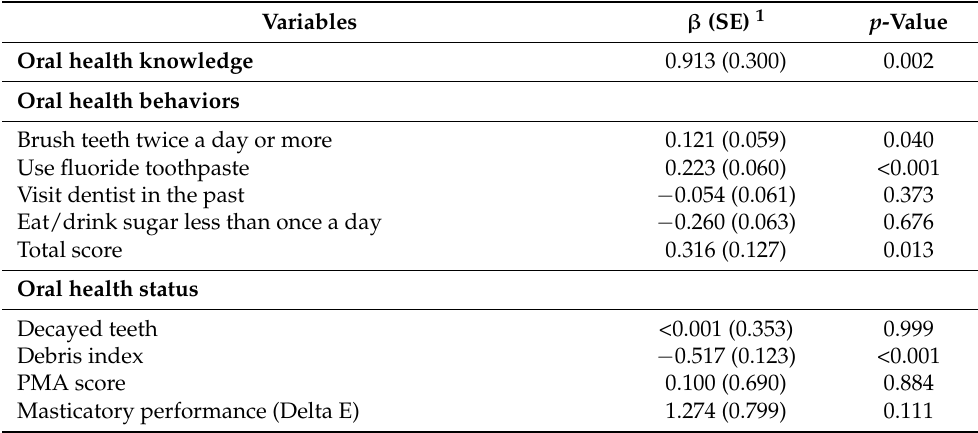
Table 3. Adjusted difference-in-difference estimates of the impact of oral health education on oral health knowledge, behavior, and clinical status.